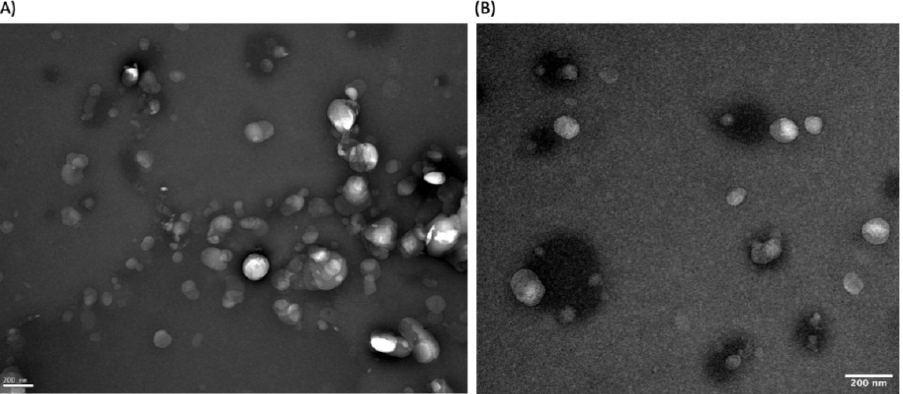
Figure 3. ( A , B ) High-resolution TEM images of different sections of freshly prepared functionalized NLC. Magnification of 50,000×